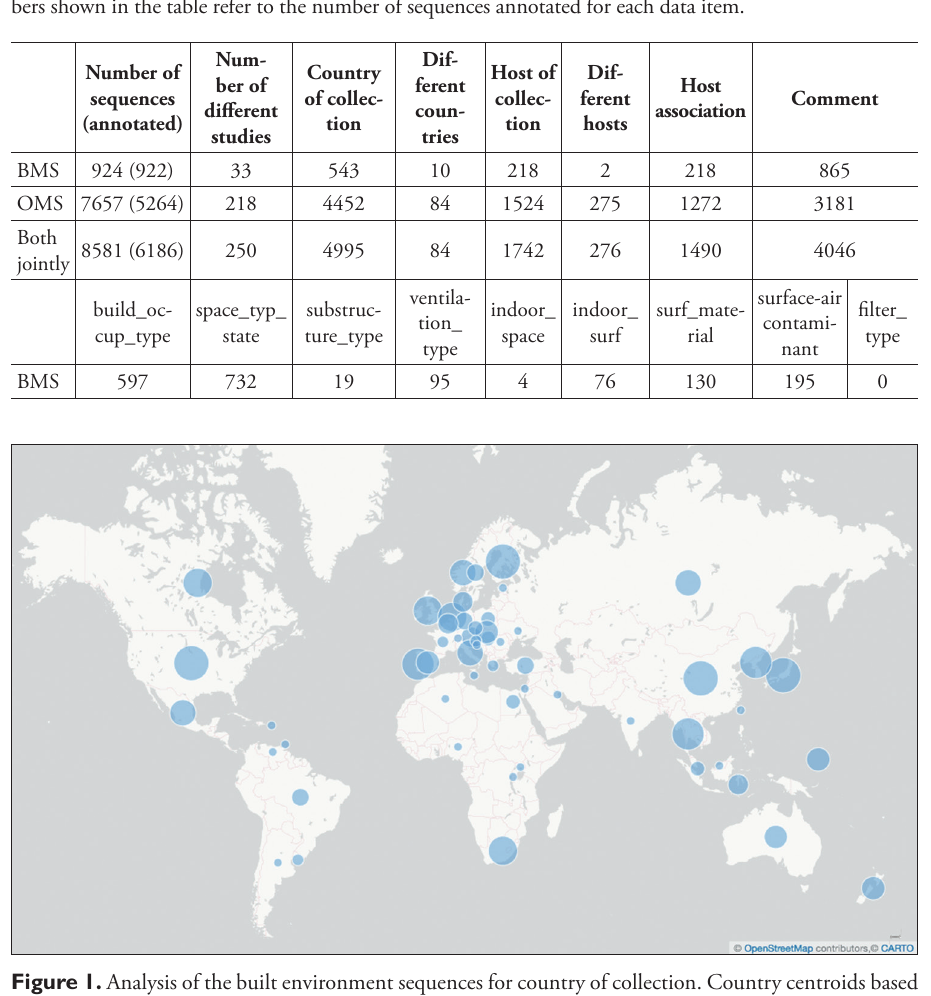
Table 3. Results of the metadata annotation part of the workshop, specified for the built mycobiome se- quence set (BMS) and the outdoor mycobiome sequence set (OMS). Country and host of collection plus host association were assembled for both of these. The number of sequences processed, plus the number of underlying published and unpublished scientific studies, are also provided. For the BMS, the nine MIxS-BE annotation standard items targeted at the workshop are specified in separate columns. The sequence num- bers shown in the table refer to the number of sequences annotated for each data item.